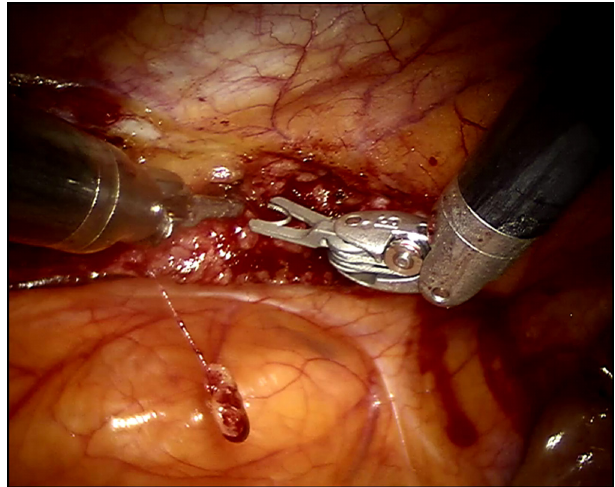
Fig. 2 – Use of endoscopic clip to ligate branch of the mammary